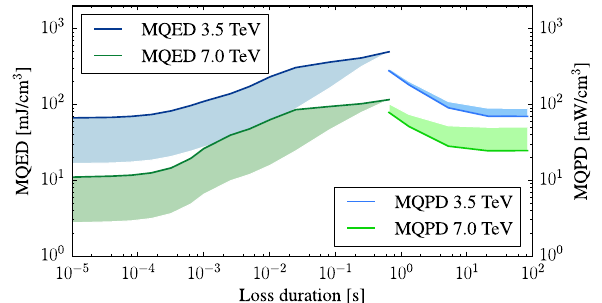
FIG. 24. Electrothermal quench level estimates for the inner layer of the LHC main bending magnet. Shading in the MQED estimates indicates uncertainties following from the analysis of the intermediate-duration orbit-bump quench test. Shading in the MQPD estimates indicates uncertainties due to the unknown cooling efficiency of intralayer spacers in the main magnets of the